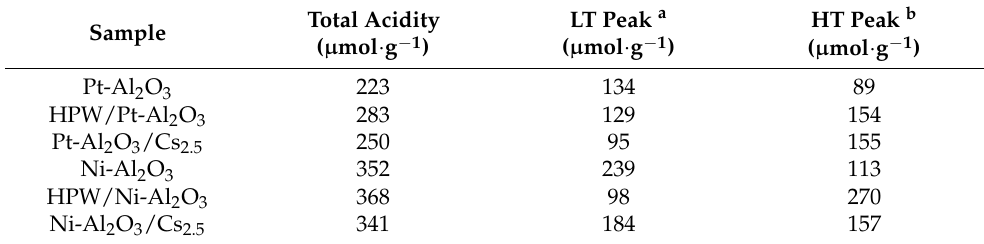
Table 1. Acidity properties of the different catalysts derived from NH 3 -TPD